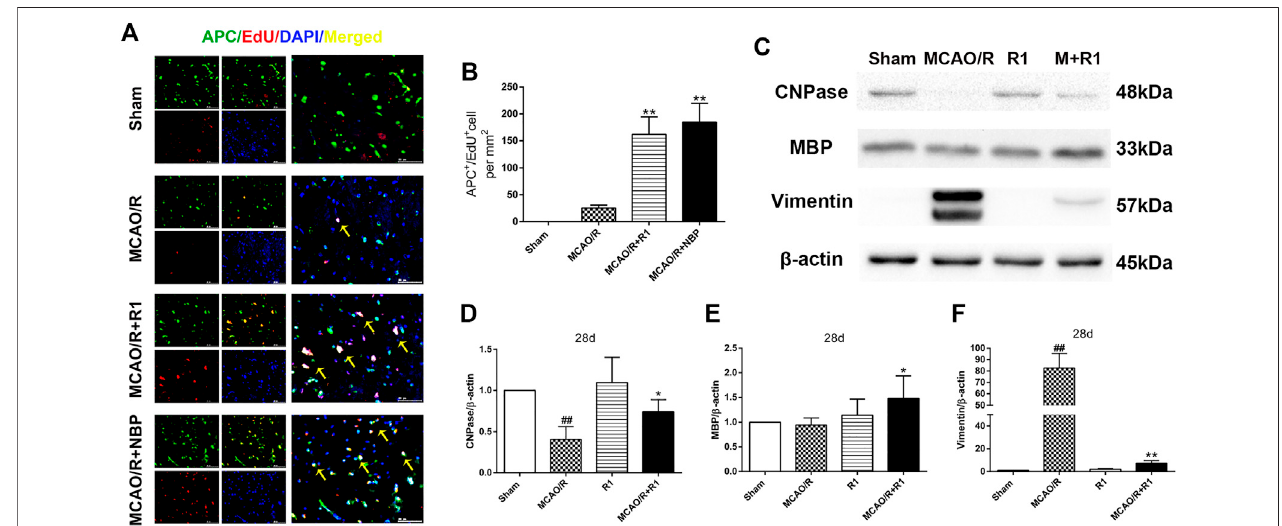
FIGURE5| R1facilitatesoligodendrogenesisandpreservesmyelinafterischemicstroke (A) Representativeimagesoftheinfarctionareacostainedwithantibodies against APC + (green, marker of oligodendrocytes) and EdU (red, marker of proliferating cells) on day 28 after R1 treatment, yellow arrows indicate proliferated oligodendrocytes(EdU + /APC + cells),DAPI(blue)indicatesthenucleus,Scalebar (cid:1) 50 μ m (B) Quantitativeanalysisofproliferatingoligodendrocytes(EdU + /APC + cells)in the cortex region after R1 treatment. n (cid:1) 3 brains per group. Representative images of immunoblotting (C) and quanti fi cation of cnpase (cyclicnucleotide 30- phosphohydrolase, D ),MBP (myelin basicprotein, E ),and vimentin (F) inthe infarct cortexregion oftheSham, MCAO/R, R1, and MCAO/R + R1groups on day 28after MCAO surgery. n (cid:1) 3 in each group. Dataare expressed asthe mean ± SD and were analyzed by ANOVA. # p < 0.05, ## p < 0.01 vs. Sham group; * p < 0.05, ** p < 0.01 vs. MCAO/R